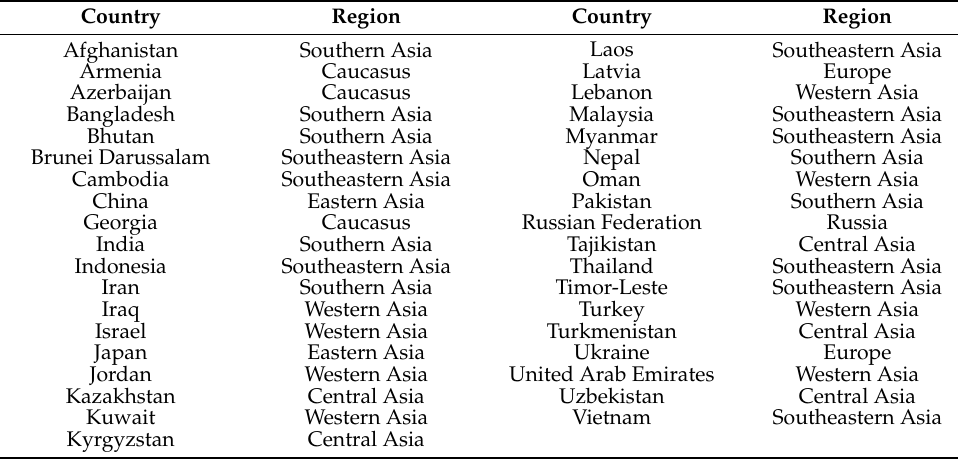
Table A1. List of countries and regions included in the study area.